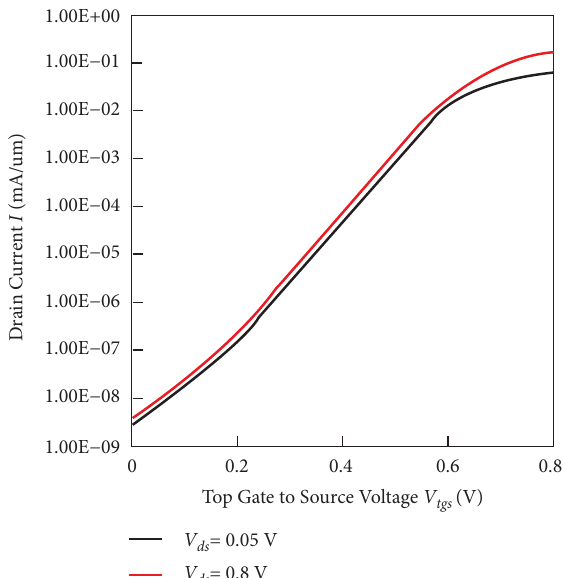
V V fgs and bgs are 0 V. ds , where